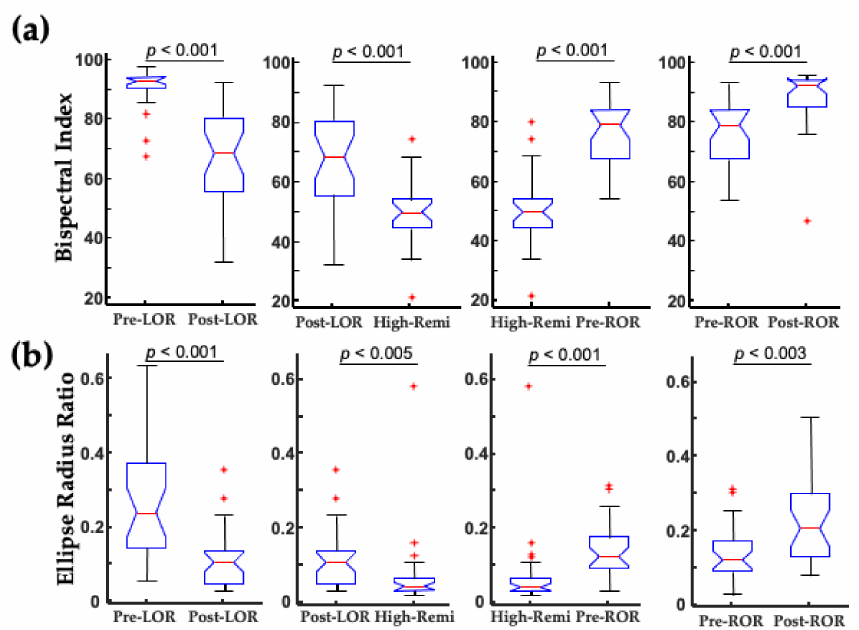
Figure 11. Ellipse radius ratio discriminates clinically relevant states as well as the bispectral index. ( a ) The bispectral index (BIS) significantly differs between the clinical loss and recovery of consciousness when a combination of remifentanil and 66% N 2 O is administered. Significant differences in BIS also occur between post-LOR and pre-ROR and deep levels of anesthesia (High-Remi, during which the highest concentration of remifentanil was administered). ( b ) Similar significant differences are observed using the geometric phase-space analysis (ellipse radius ratio). Uncorrected p -values are shown here. Box and whisker plots show the median (red line), 25th and 75th quartiles (bottom and top edges of the blue box, respectively), most extreme data points (error bars), and outliers (red plus signs). Adapted with permission from Reference